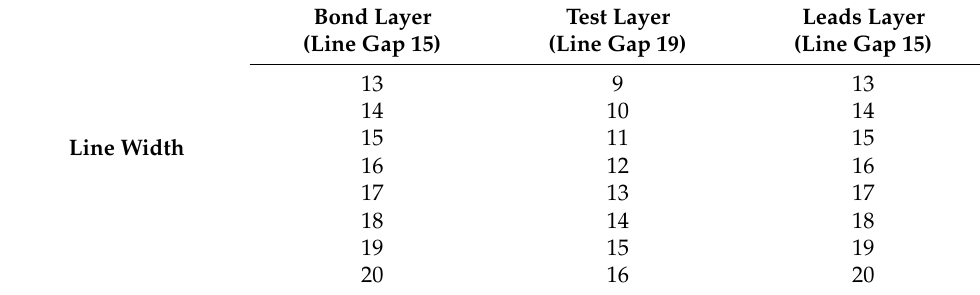
Table 2. Dimensional information of the proposed IPD BPF line width adjustment.